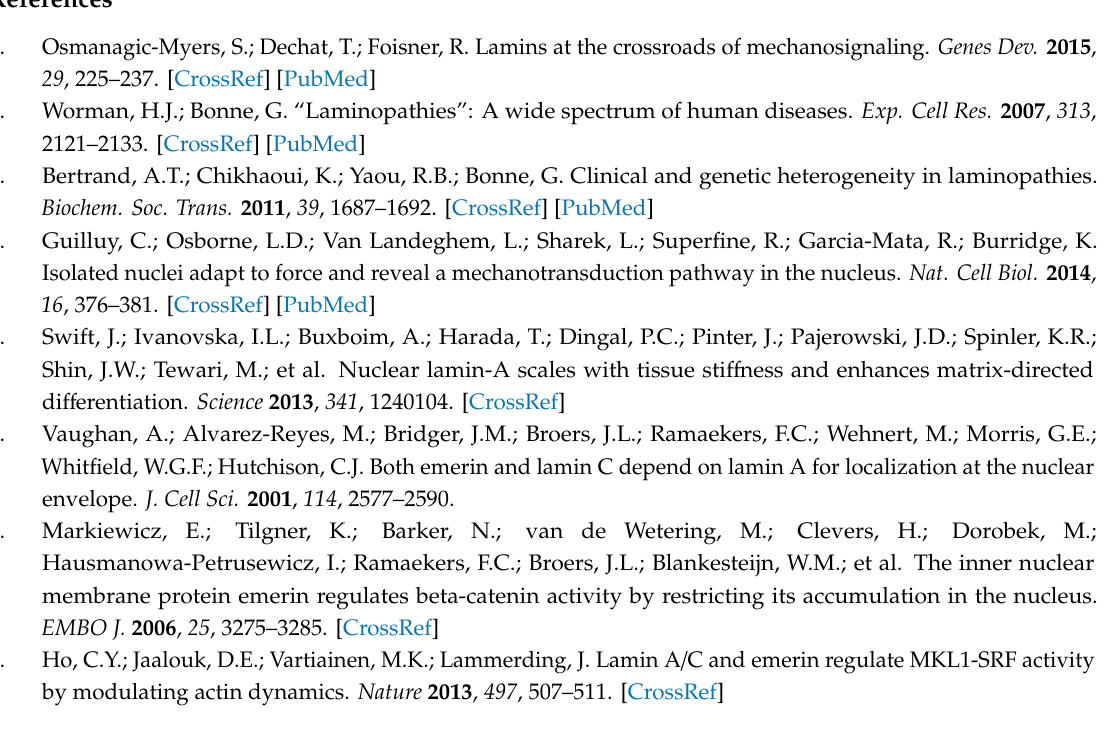
Figure S1: (A) Confocal images of YAP (green) in confluent WT and LMNA H222P myogenic cells cultured in low and high density conditions. Nuclei are stained with Hoechst (blue). Scale bar: 50 µ m. (B) Quantification of YAP nucleo-cytoplasmic (N / C) ratio. Values are expressed as mean ± SEM, n ≥ 50 cells for each cell line, Figure S2: (A) Confocal images of YAP (green) and nuclei (blue) in confluent WT MuSCs treated with Leptomycin B (LB). Scale bar = 20 µ m; (B) Confocal images of YAP (green) and nuclei (blue) in WT and LMNA ∆ K32 mutant MuSCs cultured in low and high density conditions. Nuclei are stained with Hoechst (blue). Scale bar: 20 µ m. (C) Confocal images of YAP (green) and nuclei (blue) in confluent WT MuSCs treated with latrunculin A (LatA). Scale bar = 20 µ m; (D) Quantification of YAP nucleo-cytoplasmic (N / C) ratio after Lat A treatment expressed as a fraction of control value obtained in sparse conditions. Values are expressed as mean ± SEM, n ≥ 60 cells for each cell line, *** p < 0.001 versus value obtained before LatA treatment, Figure S3: Confocal images of p 127 -YAP (green) and nuclei (blue) in WT MuSCs treated with vehicle (DMSO) or Cytochalasin D (cyto D). Scale bar = 50 µ m, Figure S4: Proposed model of the mechanisms by which lamins influence YAP subcellular distribution at high cell density. (A) In WT MuSCs plated at high cell density, the Hippo pathway is activated, and p 127 -YAP was excluded from the nucleus. YAP nuclear entry was lower than YAP nuclear export. (B) In L-CMD and nesprin-1 DKASH mutations, YAP nuclear export is insu ffi cient to counterbalance YAP nuclear entry despite activation of the Hippo pathway. This results in persistent nuclear localization of p S127 -YAP nuclear import. Potential mechanisms imply increased nuclear deformability and / or dysfunctional LINC